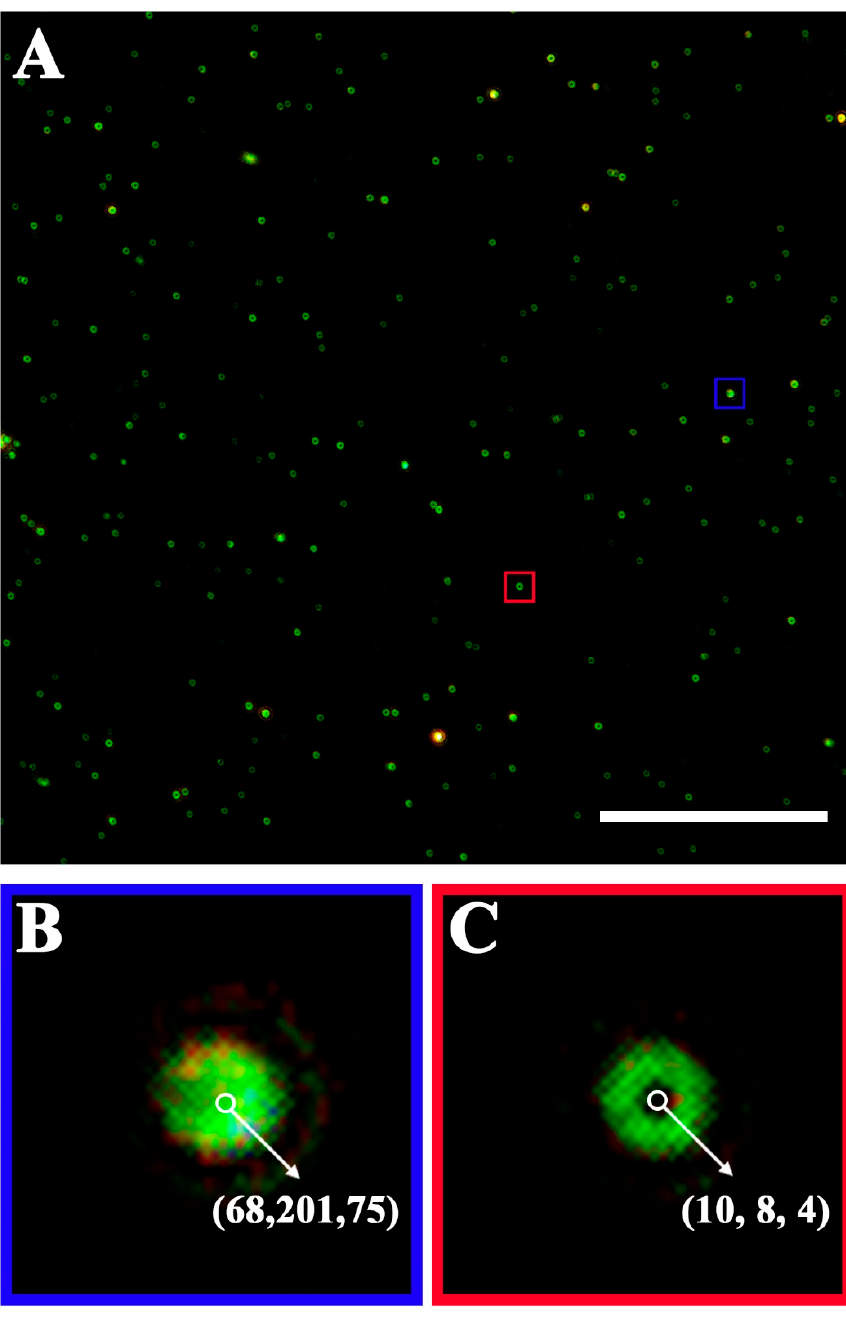
Figure 2. Identification of green halo generated by GNR. ( A ) A DFM image of the captured PEDVs labeling with GNR probes assayed by our counting software. ( B ) The enlargement of the selected area in the blue square of ( A ) and the RGB value of the center point of the green point is (68, 201, 75) by our counting software. ( C ) The enlargement of the selected area in the red square of ( A ) and the RGB value of the center point of the green halo is (10, 8, 4) by our counting software. Scale bar: 20 μ m.